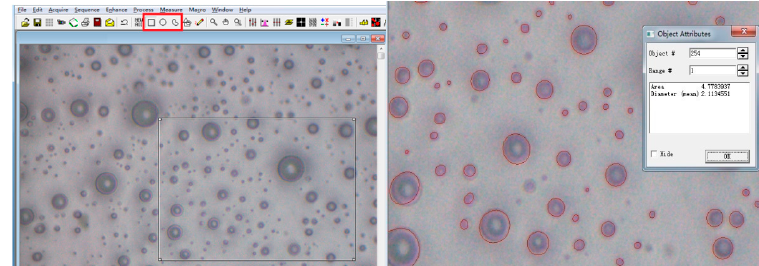
Figure 7. Calling the tool.